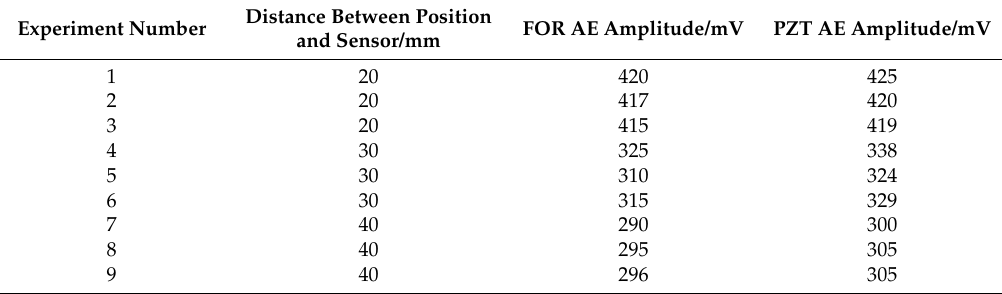
Table 1. Amplitude of broken lead signal detected by FOR and PZT AE sensors.